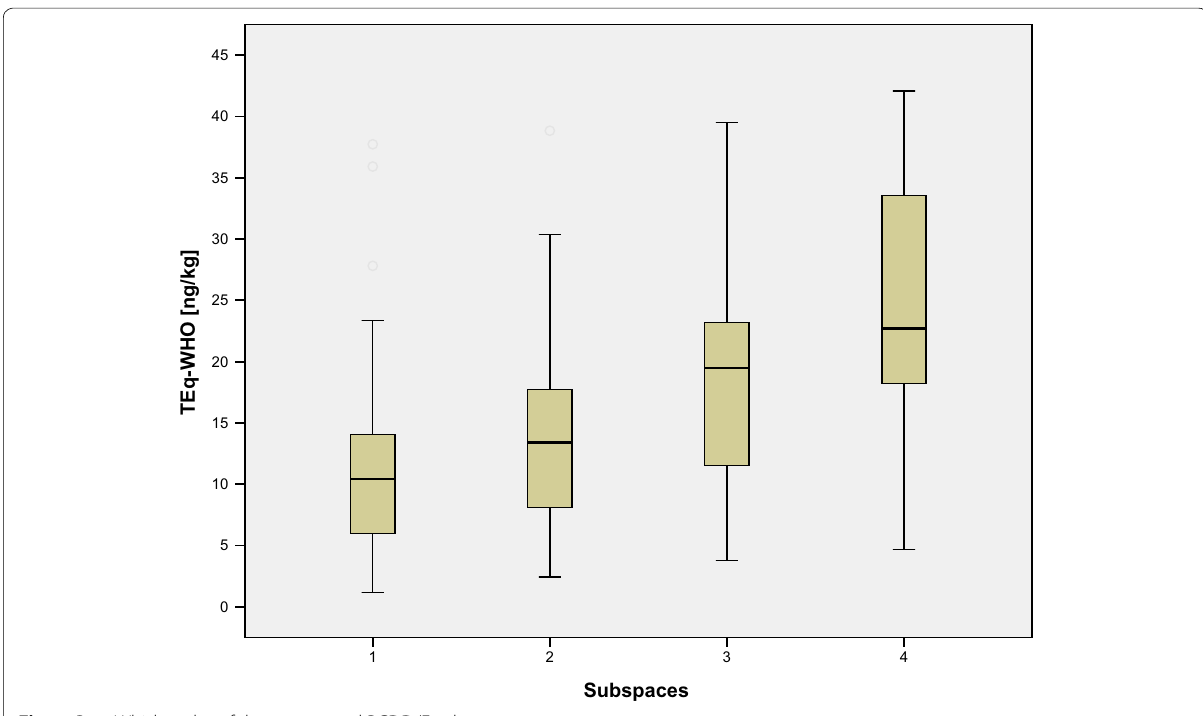
Fig. 5 Box–Whisker plot of the aggregated PCDD/F subspaces